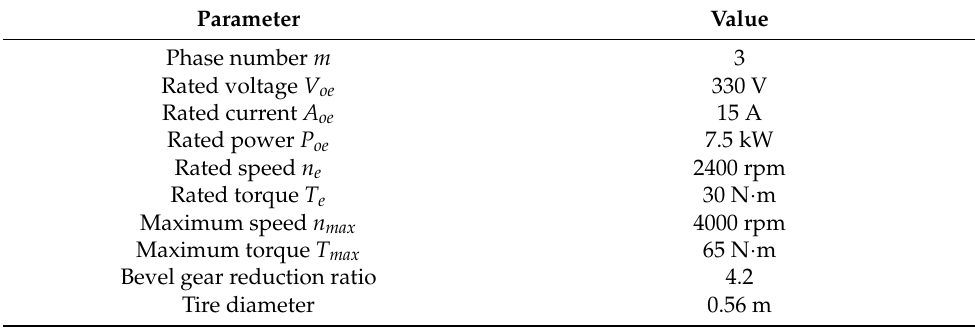
Table 1. Technical parameters of the FSPM drive system.